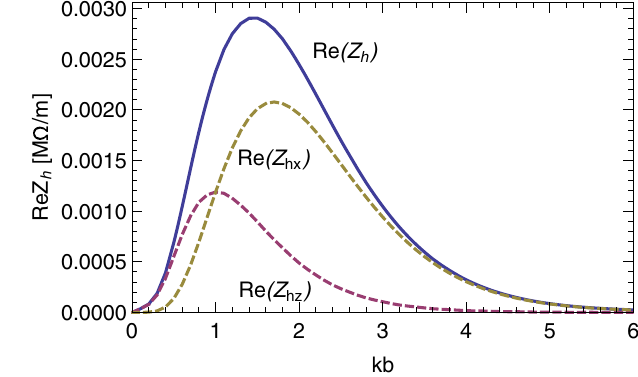
FIG. 8. The real part of the Joule heating impedance Re ð Z Þ ¼ Þ þ Re ð Z Þ for the beam passing by a single dechirper h Re ð Z hz hx plate, for the case of plate width w ¼ 12 mm (blue curve), with the constituent parts given in dashes. The beam passes by at offset b ¼ 0 . 25 mm from the plate. The area under Re ð Z Þ [Re ð Z Þ ] hz hx is 0.9% [2.4%] that under Re ð Z Þ , the beam impedance curve given in Fig.